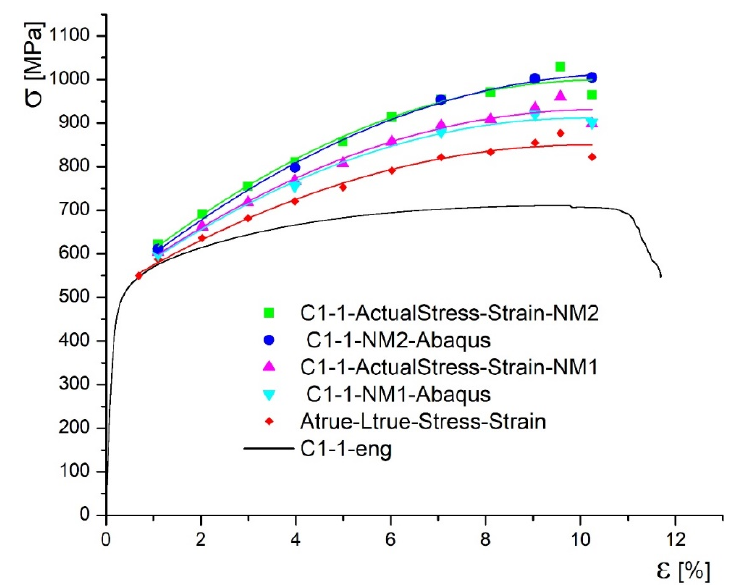
Figure 10. Actual stress–strain diagrams for the specimen C1-1.